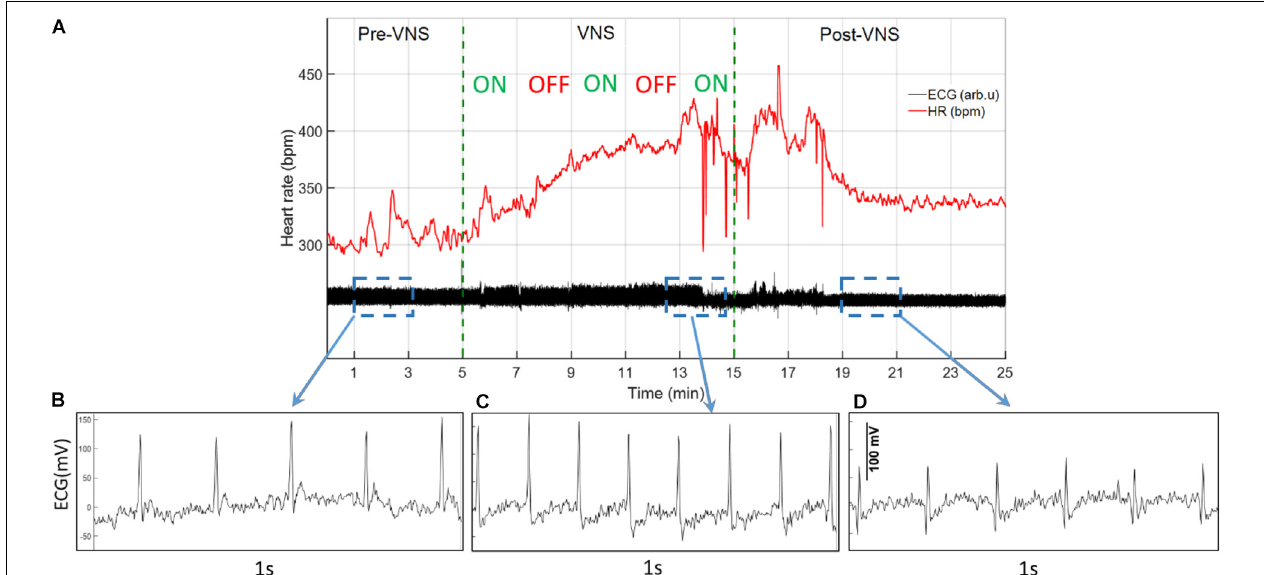
FIGURE 2 | A sample ECG recording and estimated instantaneous heart rate (HR) from a male rat during VNS. (A) ECG signal and estimated HR before, during, and after a VNS session. (B–D) 1s ECG snippet for baseline (Pre-VNS), stimulation (VNS), and recovery (Post-VNS), respectively, indicating cardiovascular changes associated with the